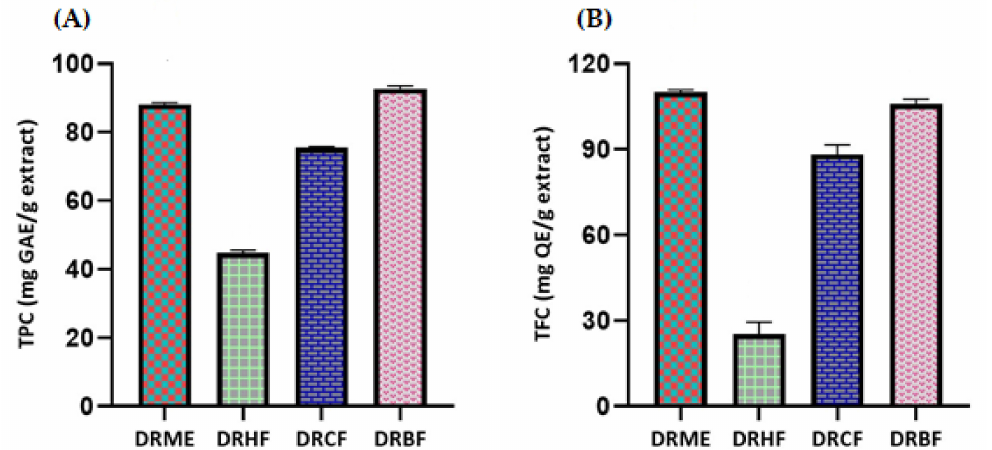
Figure 1. ( A ) Total phenolic contents (TPC) and ( B ) total flavonoid contents (TFC) of Dracaena reflexa extract/fractions. DRME: methanolic extract; DRHF: n -hexane fraction; DRCF: chloroform fraction; and DRBF: n -butanol fraction. Table 2. TPC, TFC, DPPH, ABTS, CUPRAC, and FRAP values for extract/fractions of Dracaena reflexa . Extract/